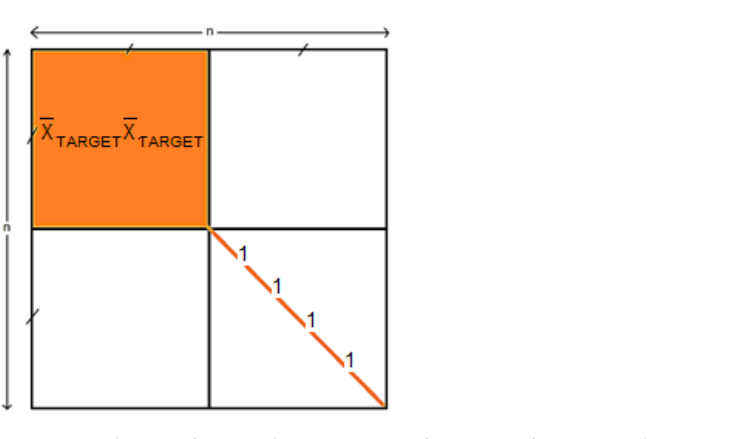
Figure 6. Schema of a correlation matrix of size n . Information that was removed (resp. retained) from the correlation matrix before being vectorized is highlighted in orange (resp. white).